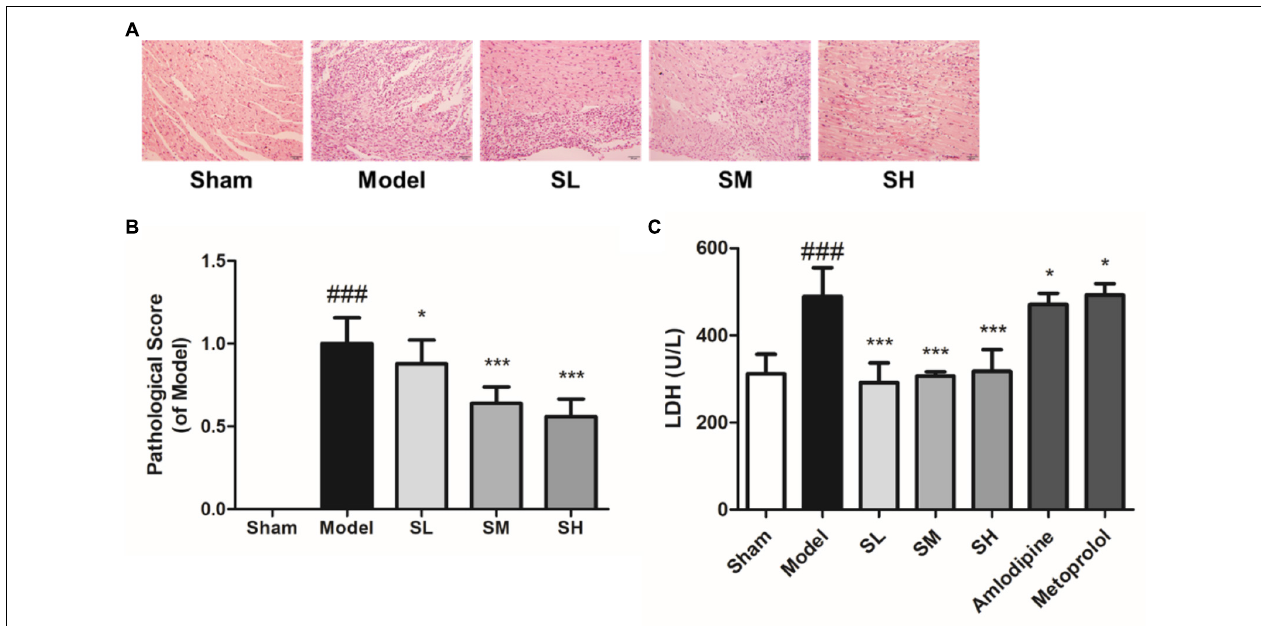
FIGURE 7 | The histopathological staining and serum LDH of AMI mice treated with Schisandra . Sham group: subjected to the same surgical treatment without ligation, SL group: Schisandra extract was given to mice at the dose of 0.056 g/kg, SM group: Schisandra extract was given to mice at the dose of 0.23 g/kg, SH group: Schisandra extract was given to mice at the dose of 0.90 g/kg. (A) Mice heart sections were stained with H&E after given corresponding drug for two days (200 × ); (B) Pathological scores of H&E staining; (C) Serum LDH was tested after 2 days treatment of Schisandra . All data are shown as the mean ± SD. ### P < 0.001 vs. Sham group; ∗ P < 0.05, ∗∗∗ P < 0.001 vs. Model group.